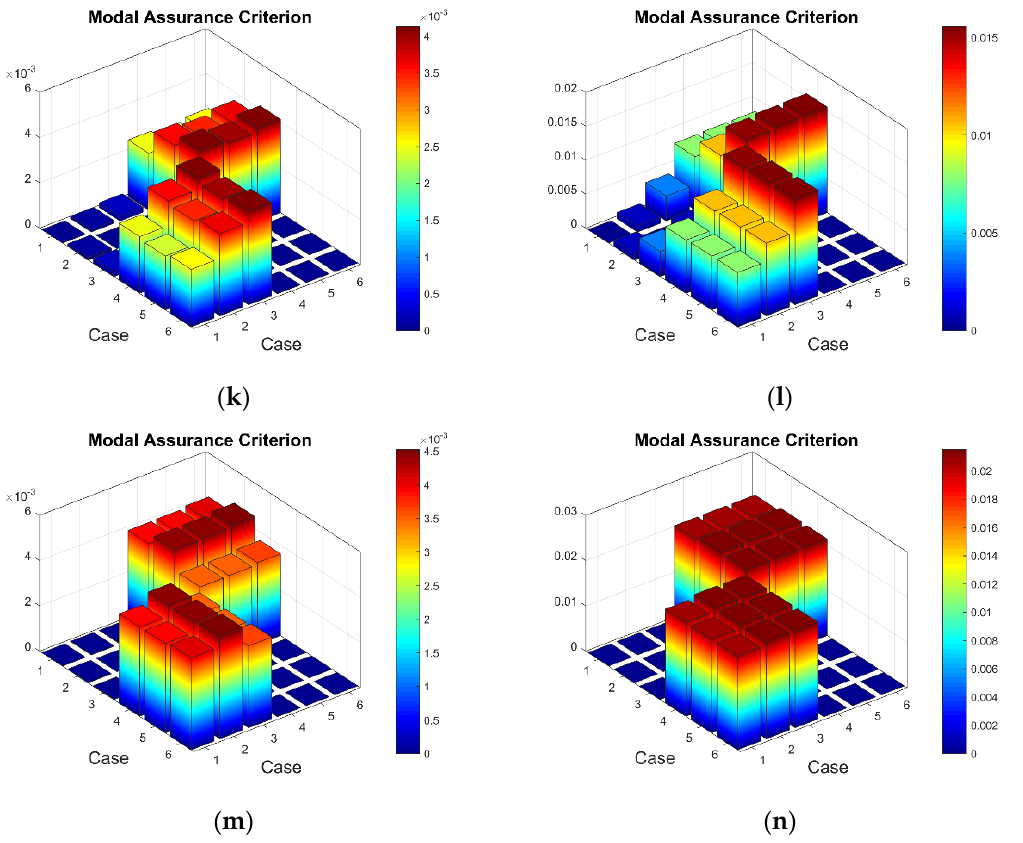
Figure A1. The MAC values comparing strain data between two experimental setups for subsequent frequencies for ( a , c , e , g , i , k , m ) the healthy plate and ( b , d , f , h , j , l , n ) the damaged plate.